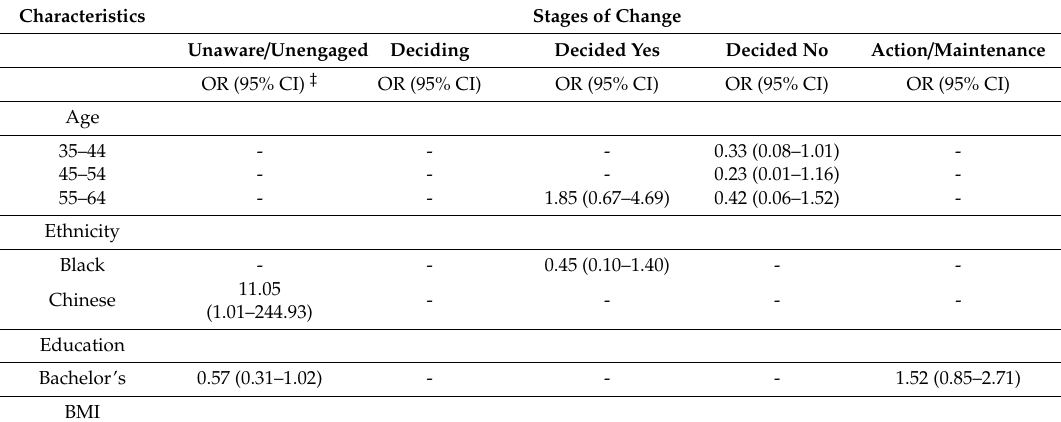
Table 7. Backward stepwise logistic regression of stage of change by demographic factors in the SB